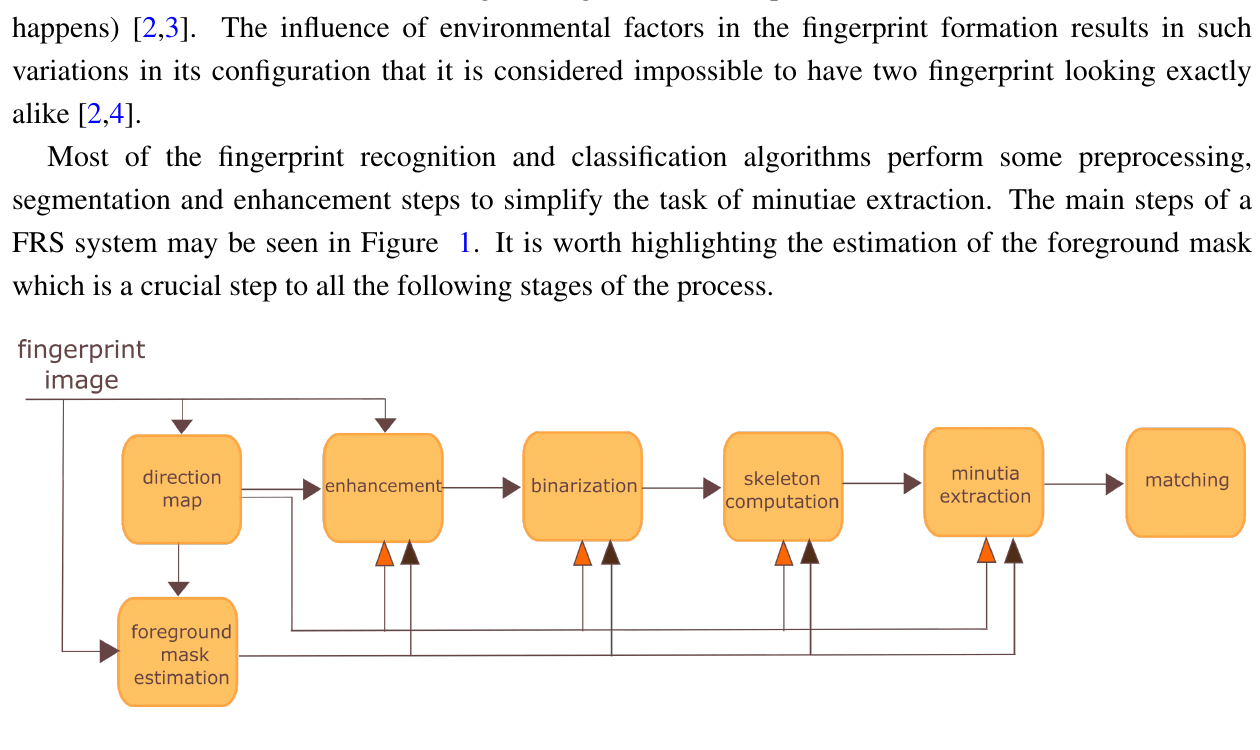
Figure 1. Fingerprint recognition system block